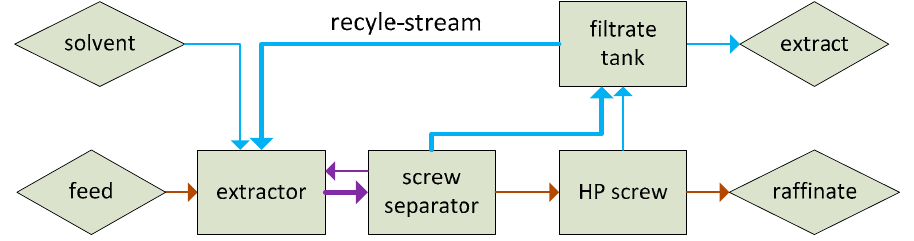
Figure 1. Suspension extraction with and without recycling. Diamonds represent streams. Rectangles represent process units. Arrows represent mass flows. Brown: solids, purple: slurry, blue: liquid.